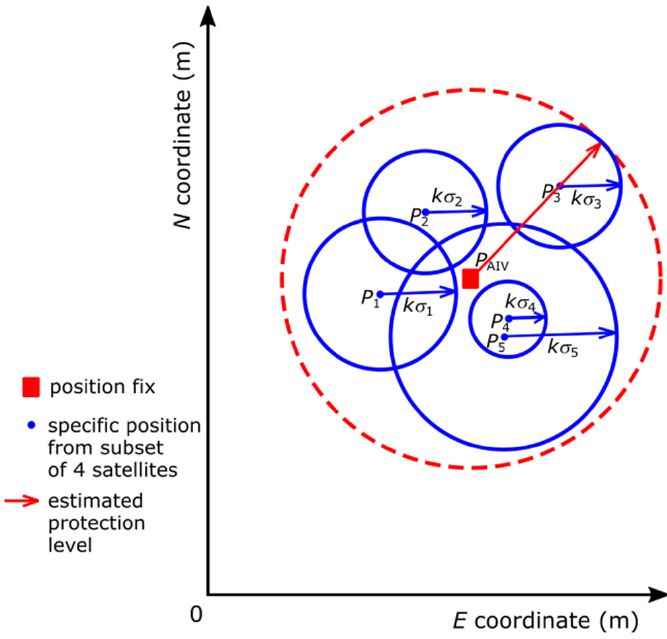
Figure 12. Determination of HPL by high level RAIM (based on [14]).